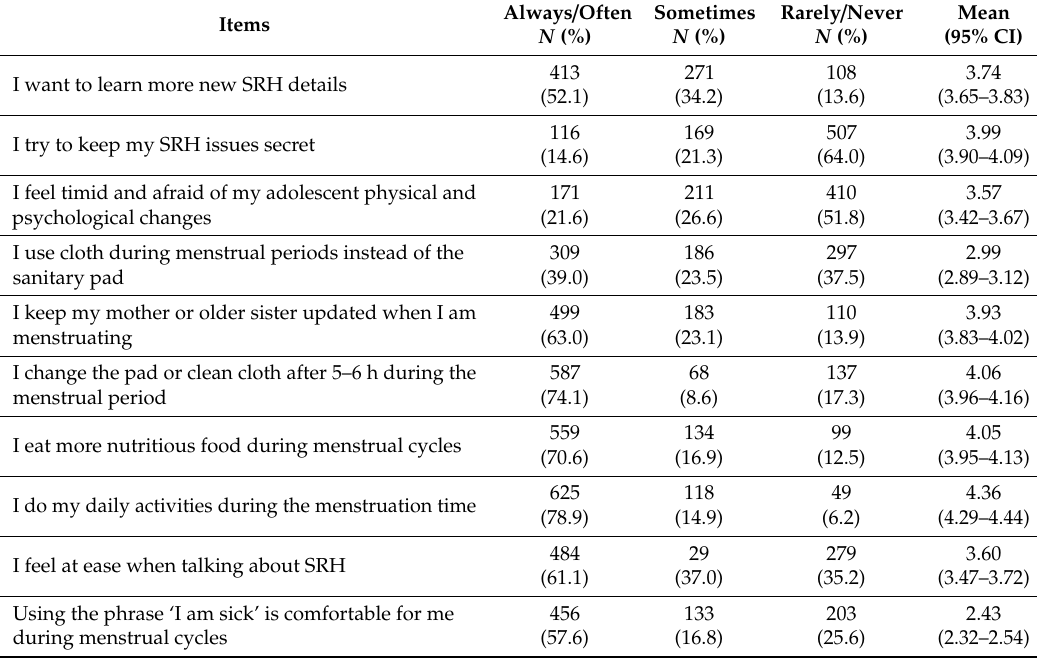
Table 4. SRH practice-related items of older adolescent